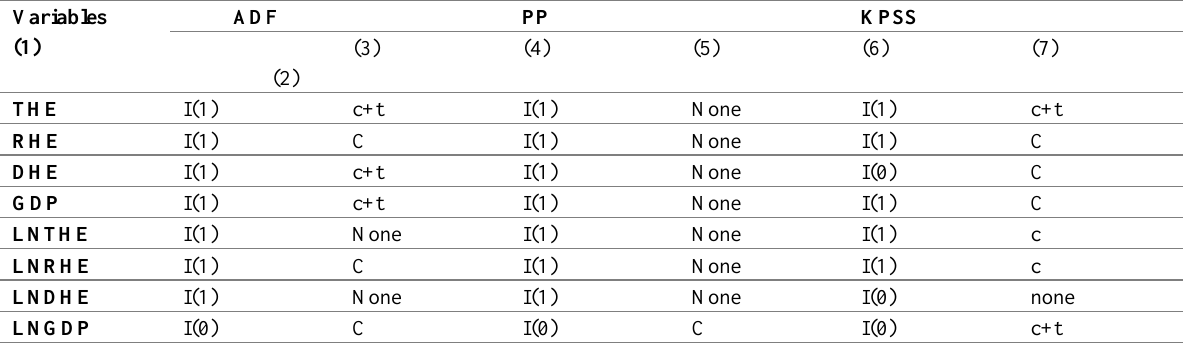
Table 2: Summary on